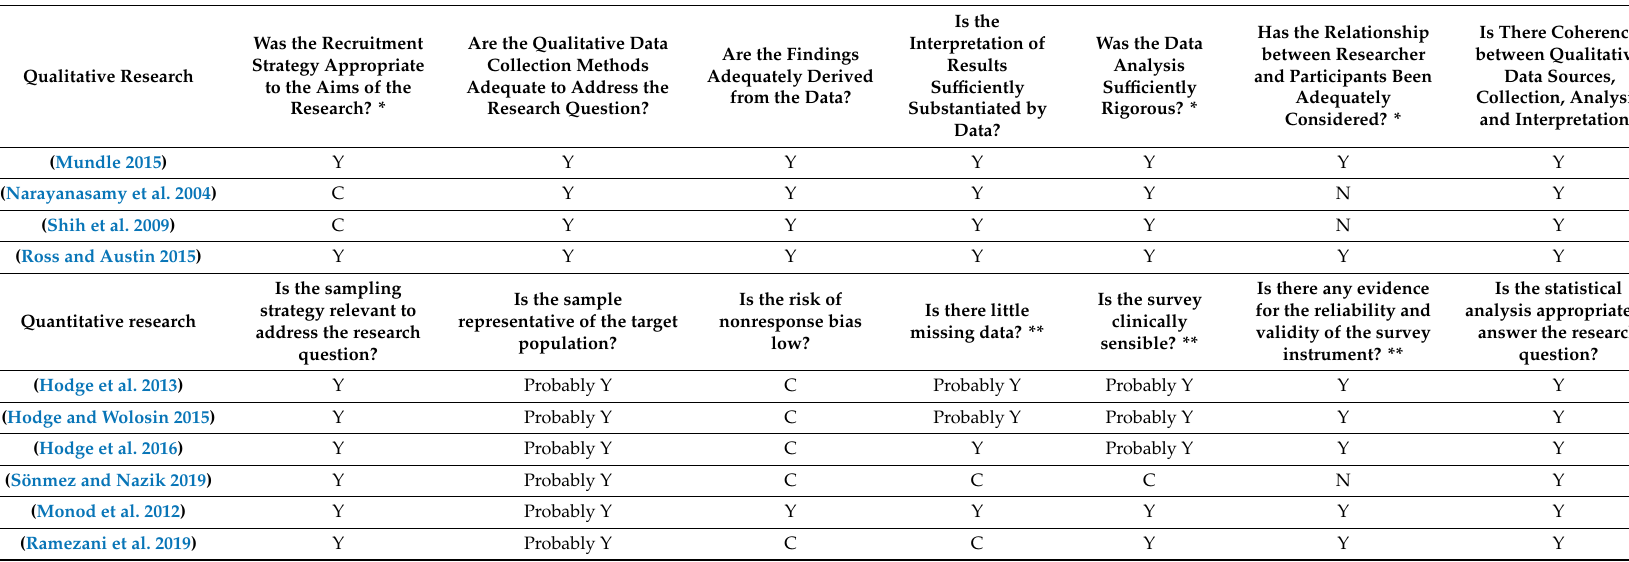
Table 2. Overview of the quality appraisal using Mixed Methods Appraisal Tool (Hong et al. 2018). Probably Y = probably yes = some aspects of the questions are confirmed in the study-others not, Y = yes, C = can’t tell, N =